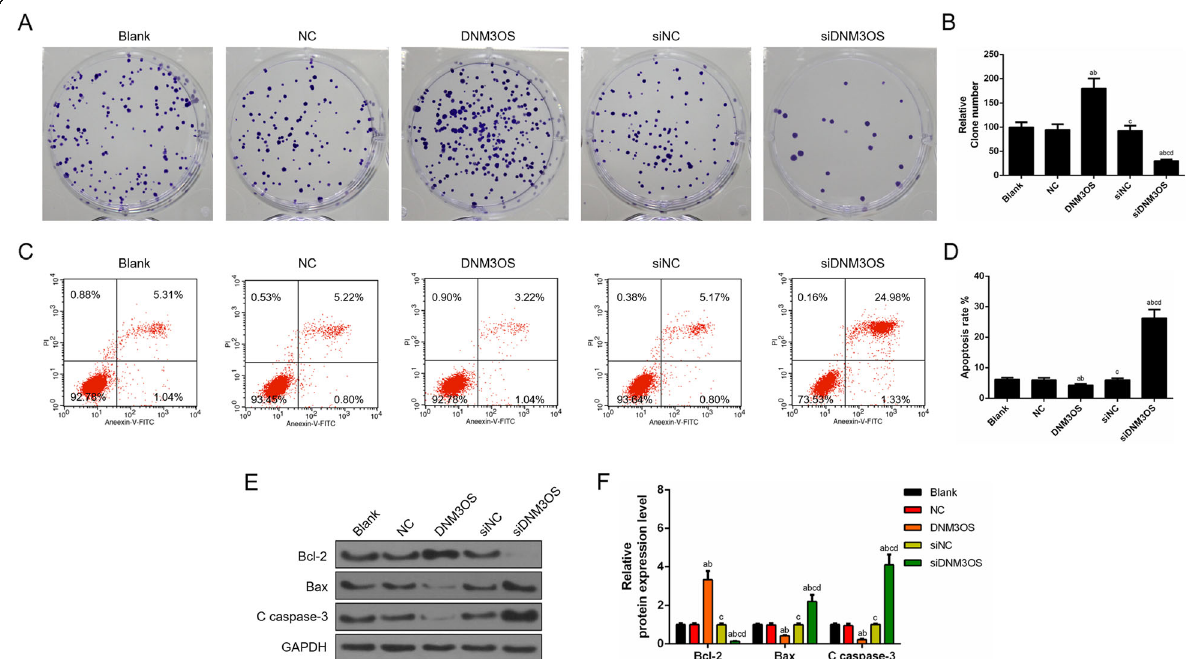
Fig. 2 Over-expression of DNM3OS enhanced proliferation and suppressed apoptosis in CHON-001 cells, while DNM3OS silencing had opposite effects. ( a ) CHON-001 cells proliferation was improved by DNM3OS, while silencing DNM3OS inhibited CHON-001 cells proliferation as indicated by cloning formation experiment. ( b ) The number of proliferated cells was quantified. ( c ) CHON-001 cells apoptosis was inhibited by DNM3OS, while DNM3OS silencing induced apoptosis as indicated by flow cytometry. ( d ) The proportion of apoptosis was quantified. ( e ) The apoptosis- related proteins (Bcl-2, Bax and c caspase 3) were detected by Western blot. ( f ) The relative levels of proteins described in ( e ) were counted by GAPDH as normalization. a P < 0.05 vs. Blank, b P < 0.05 vs. NC, c P < 0.05 vs. DNM3OS, d P < 0.05 vs. siNC. siDNM3OS: small interfering dynamin 3 opposite strand; NC: negative control; Bcl-2: B-cell lymphoma-2; Bax: Bcl2-associated X